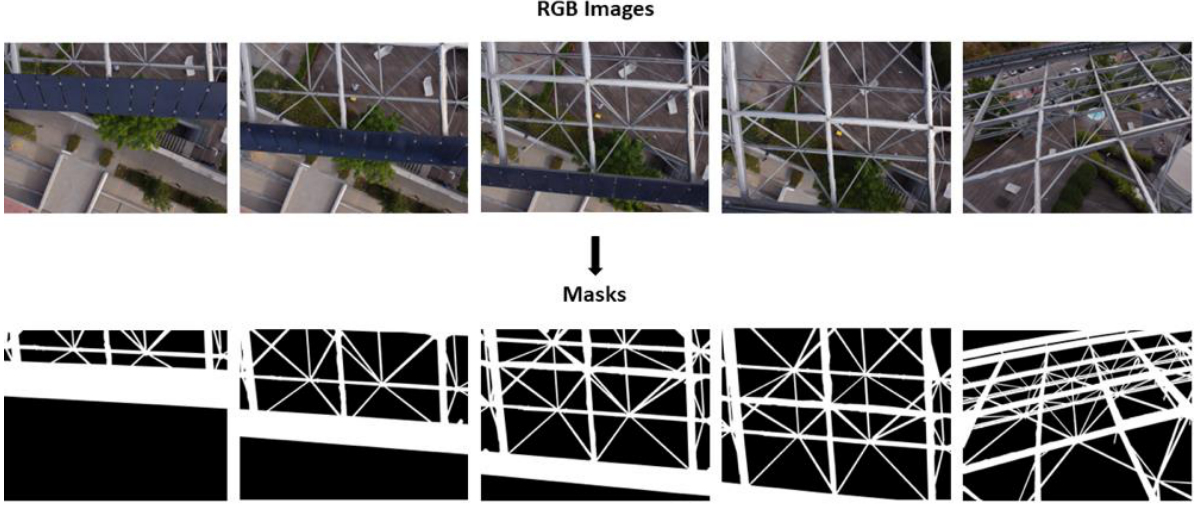
Figure 13. Creation of the training set masks.